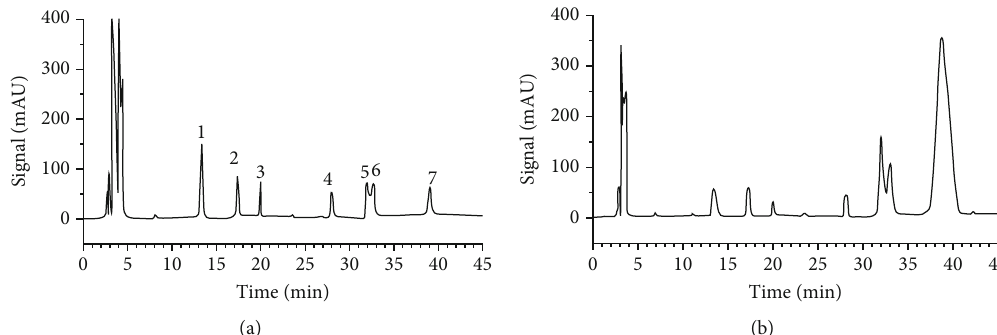
Figure 2: HPLC separation of PMP-labeled monosaccharide composition of cSFP-C: (a) monosaccharides standard; (b) cSFP-C. Peaks: 1: mannose; 2: rhamnose; 3: glucuronic acid; 4: glucose; 5: galactose; 6: xylose; 7: fucose. Table 2: Molar ratio of monosaccharide composition in cSFP-C. Glc